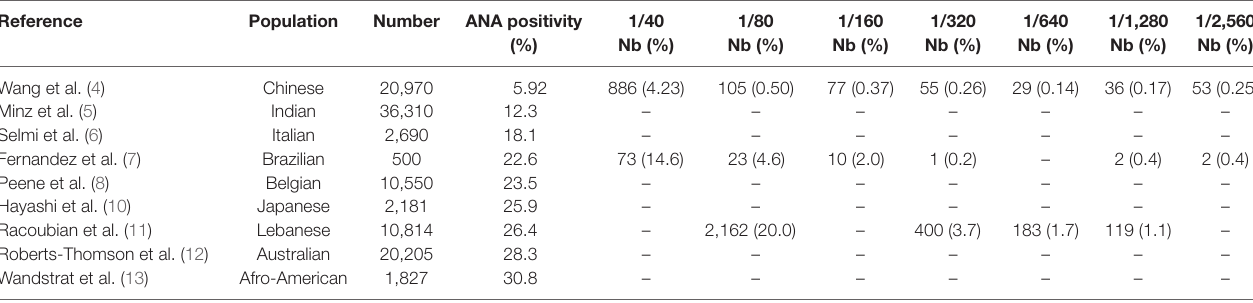
TAble 1 | Presence of antinuclear antibody (ANA) in different populations considered as healthy people.